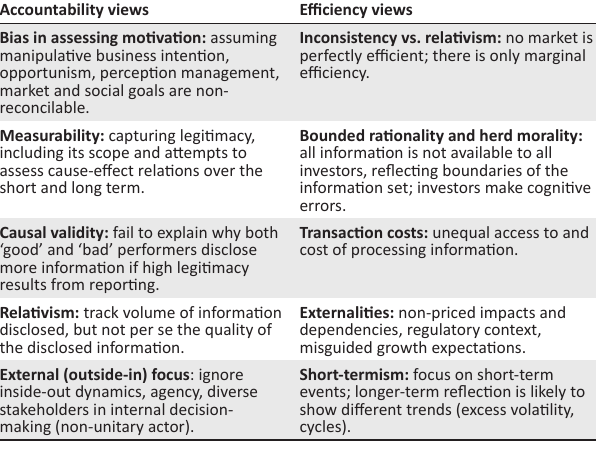
TABLE 2: Perceived weaknesses of accountability and efficiency